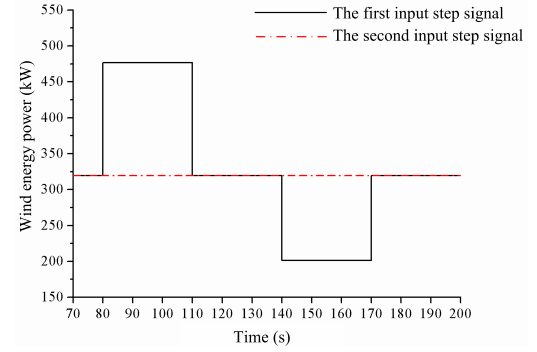
Figure 13. Wind energy power curve.